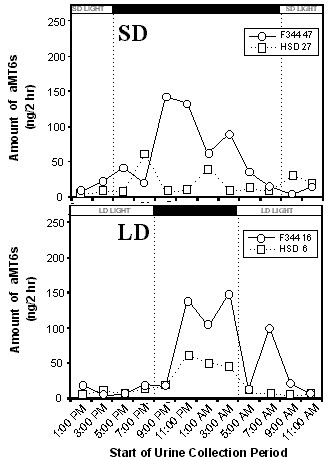
24-hour urinary 6-sulfatoxymelatonin excretion rhythms (ng/2 h) for two individual F344 rats (one in SD and one in LD) and two individual HSD rats (one in SD and one in LD). Bars at the top of the figure indicate periods of light and dark for the SD (upper panel) and LD (lower panel) treatments. The four rats selected for presentation were those with the lowest total 6-sulfatoxymelatonin excretion in their respective treatment groups.